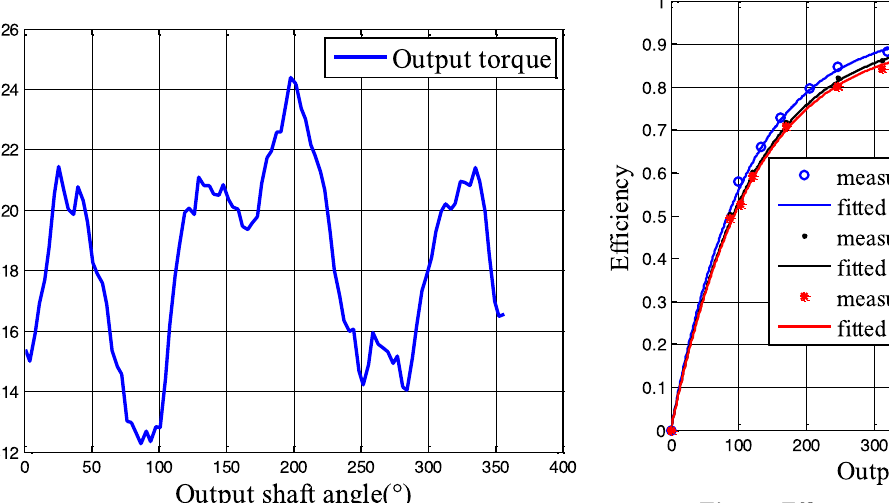
Fig. 6. Ef fi ciency curves at different